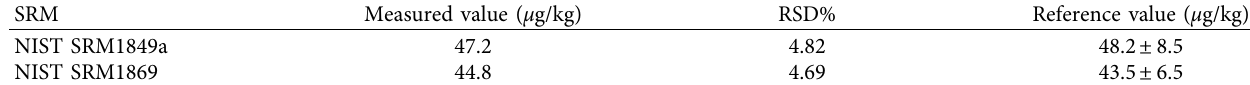
Table 3: Results of vitamin B